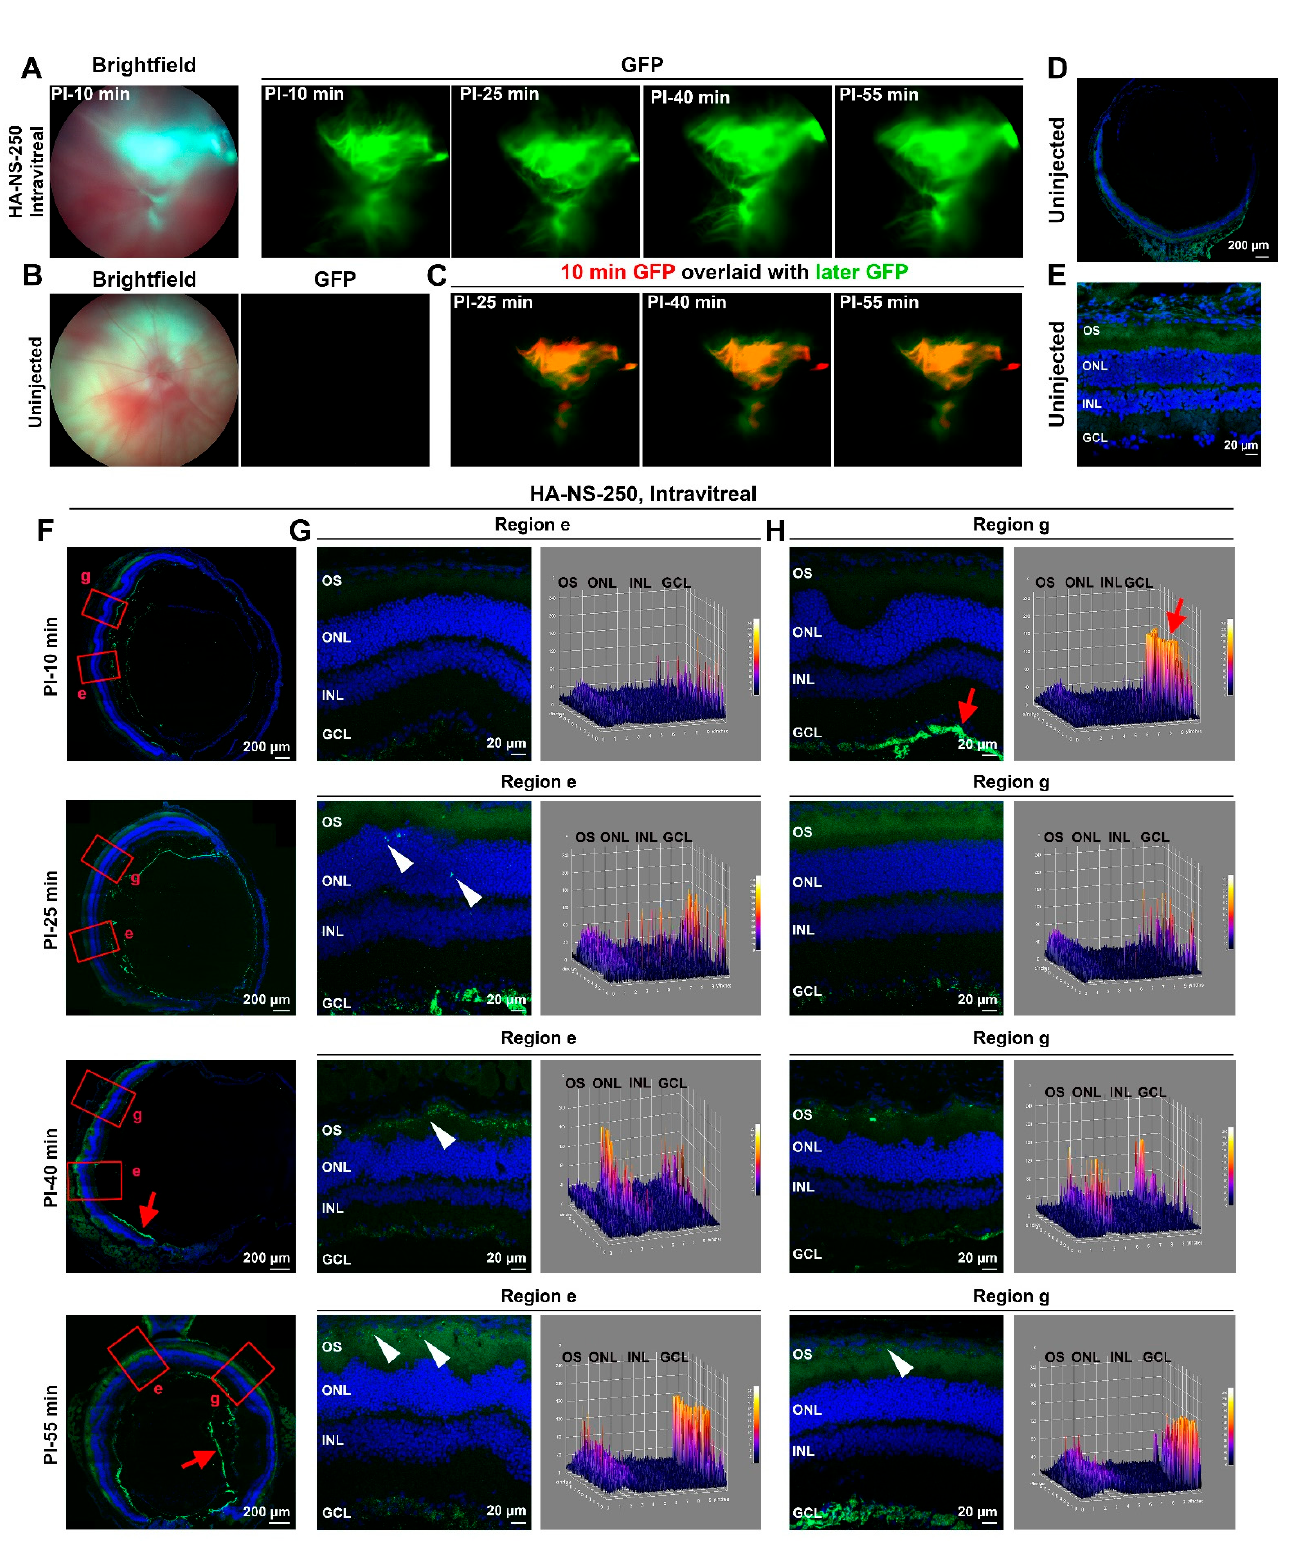
Figure 2. Short-term distribution of HA-NS-250 after intravitreal injection. Adult Balb/C mouse eyes were intravitreally injected with 2 µL of HA-NS-250 (5.8 × 10 6 HA-NS-250/µL). ( A , B ) Fundus images were taken using white light (left panel, ( A , B ) or GFP filters (all other panels in ( A , B )) at time points ranging from PI-10 min to PI-55 min. ( C ) To observe how distribution of the HA-NS-250 signal changes over time, the PI-10 min image is shown pseudocolored red with subsequently captured images (PI-25, 40 and 55 min) overlaid in green. ( D , E ) Shown are representative images from uninjected control eyes. ( F – H ) Injected eyes were harvested at the indicated timepoints and serially cryosectioned ( n = 3). ( F ) Shown